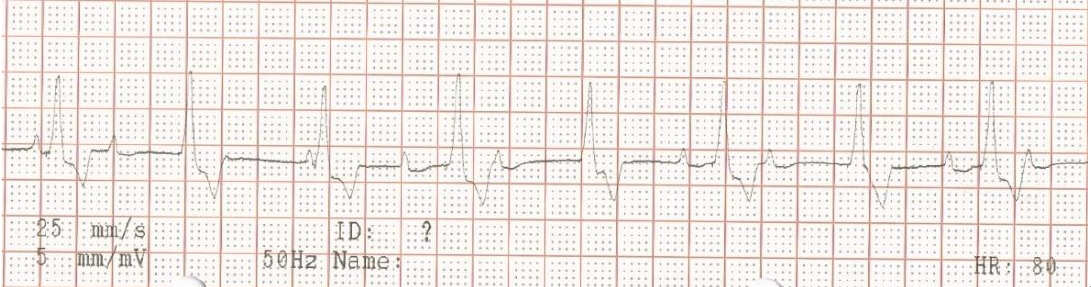
Figure 5. Surface electrocardiogram at the appearance of lethargy, 5 days after pacemaker implan- tation. Lead aVF shows paced ventricular QRS-complexes with 100% capture and atrio-ventricular dyssynchrony, compatible with an appropriately functioning pacemaker with ventricular single- chamber (VVIR) pacing mode.